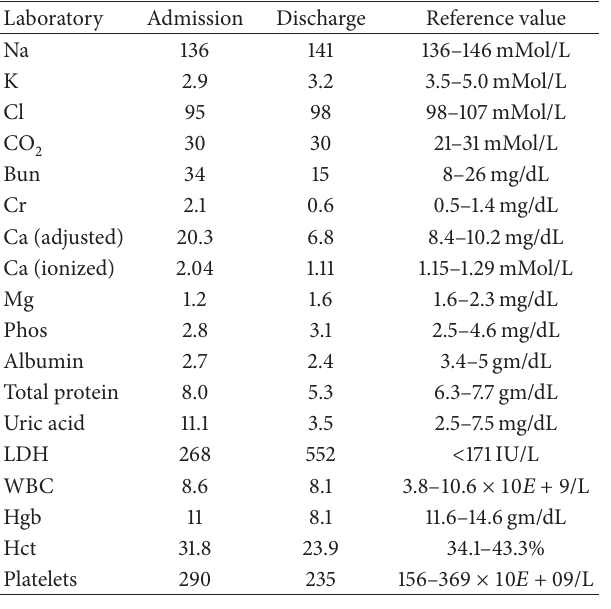
Table 1: Laboratory values at presentation and discharge with UPMC reference values.